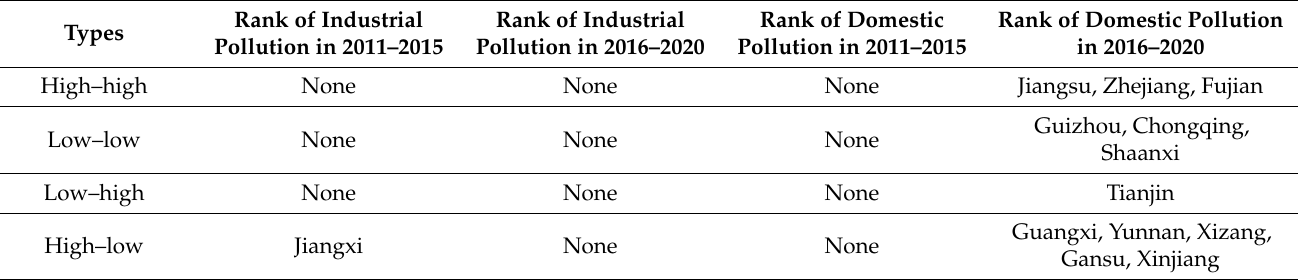
Table 6. Local Moran’s I of ranks in four economic